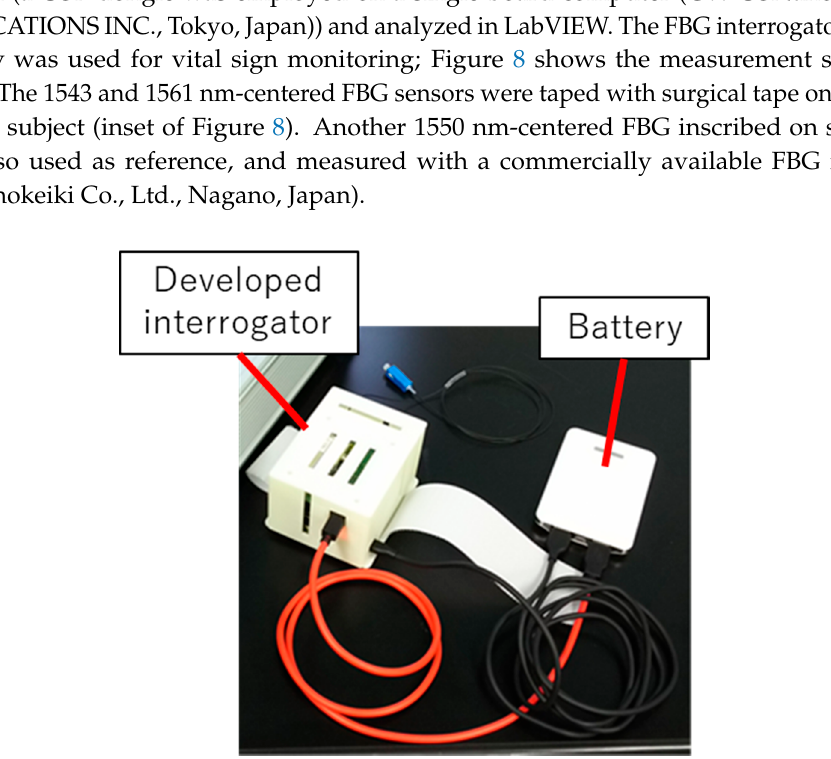
Figure 7. The casing of the interrogator (left). The edge filter module, single-board computer and smaller AD board are encased. A portable battery (right) supplies the power.